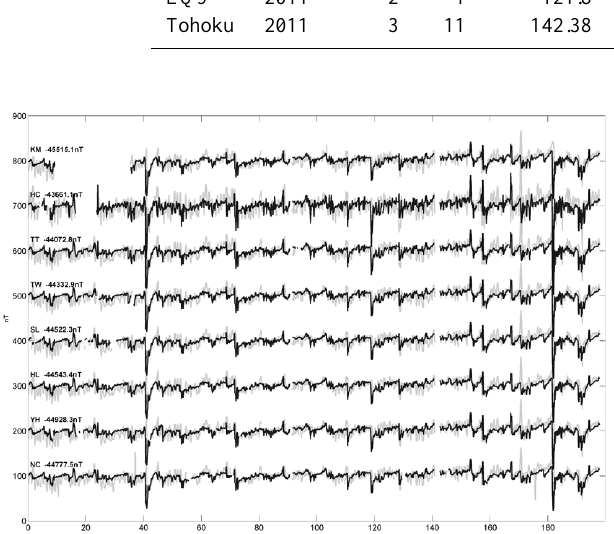
Fig. 2. Variations of geomagnetic field at 8 stations in Taiwan from 1 September 2010 to 17 March 2011. Shadow and black lines de-